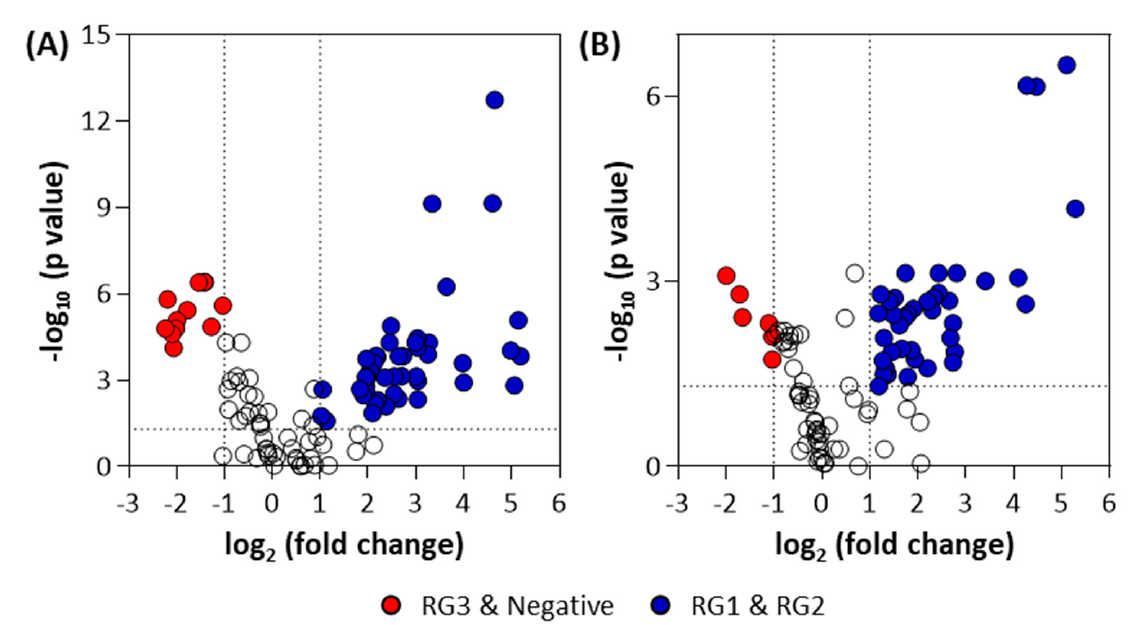
Figure 5. Volcano plots for ( A ) bacterial pellet and ( B ) bacterial supernatant samples collected from BPW cultures ( n = 36; note, the negative group includes Salmonella). Note: The colored circles in each panel represent each detected significant metabolite. The open black circles represent statistical non-significant ( p -value > 0.05) metabolites.